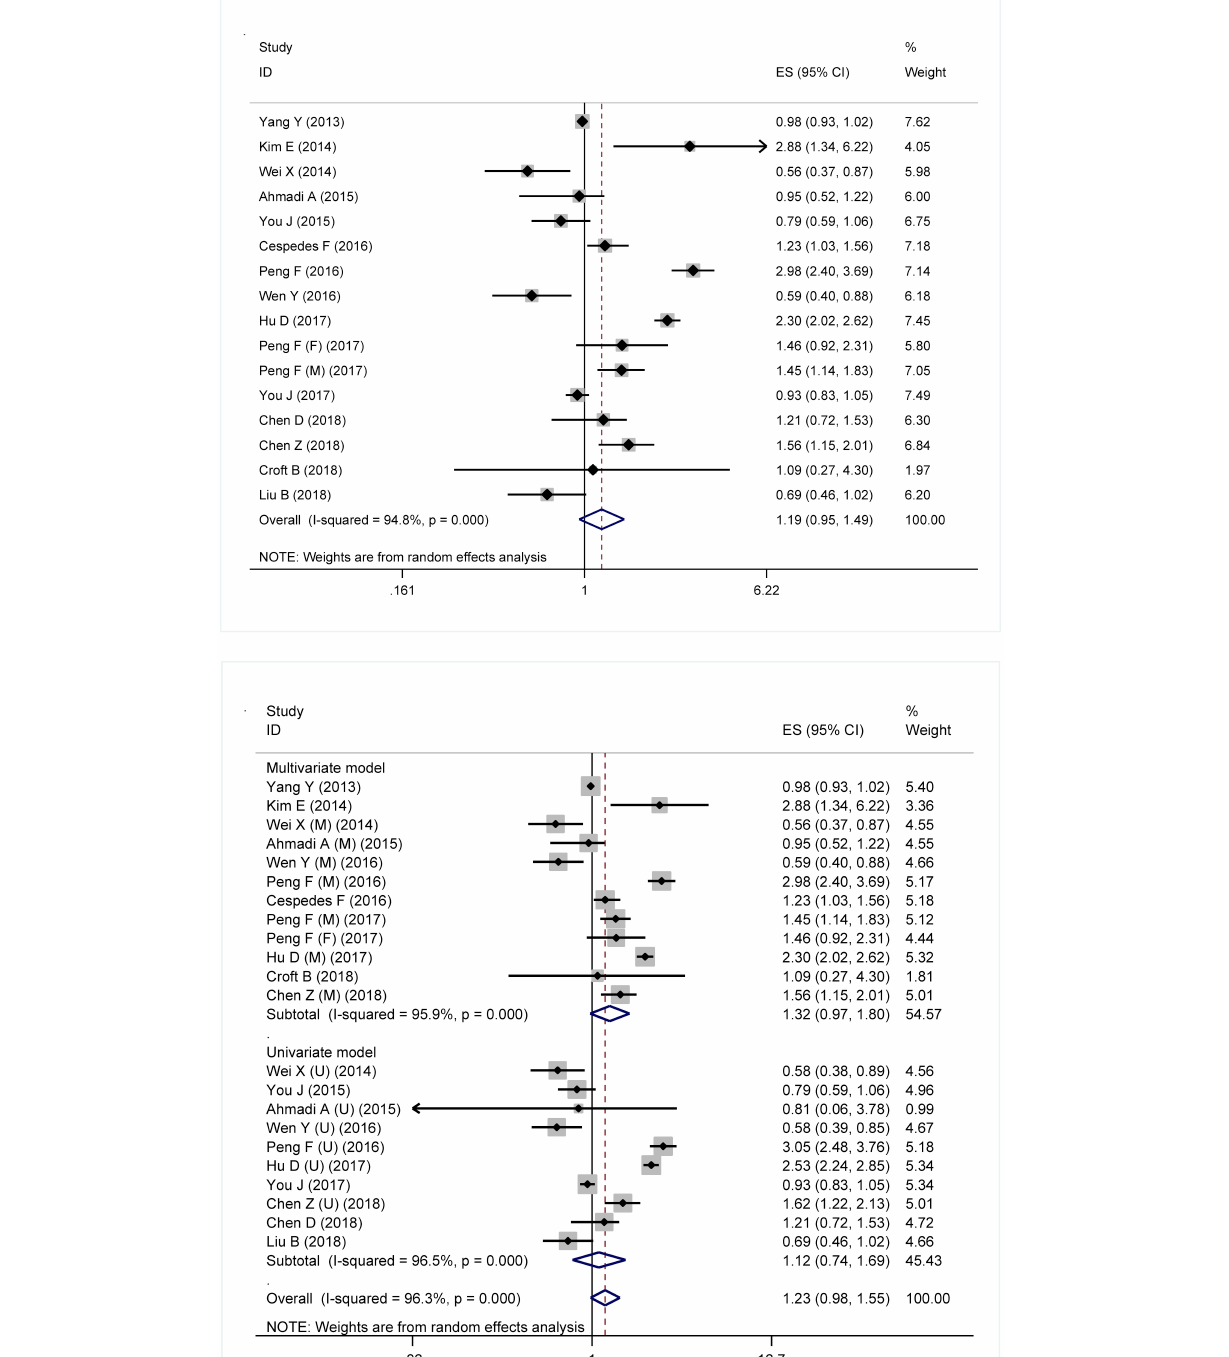
Frontiers in Oncology | www.frontiersin.org